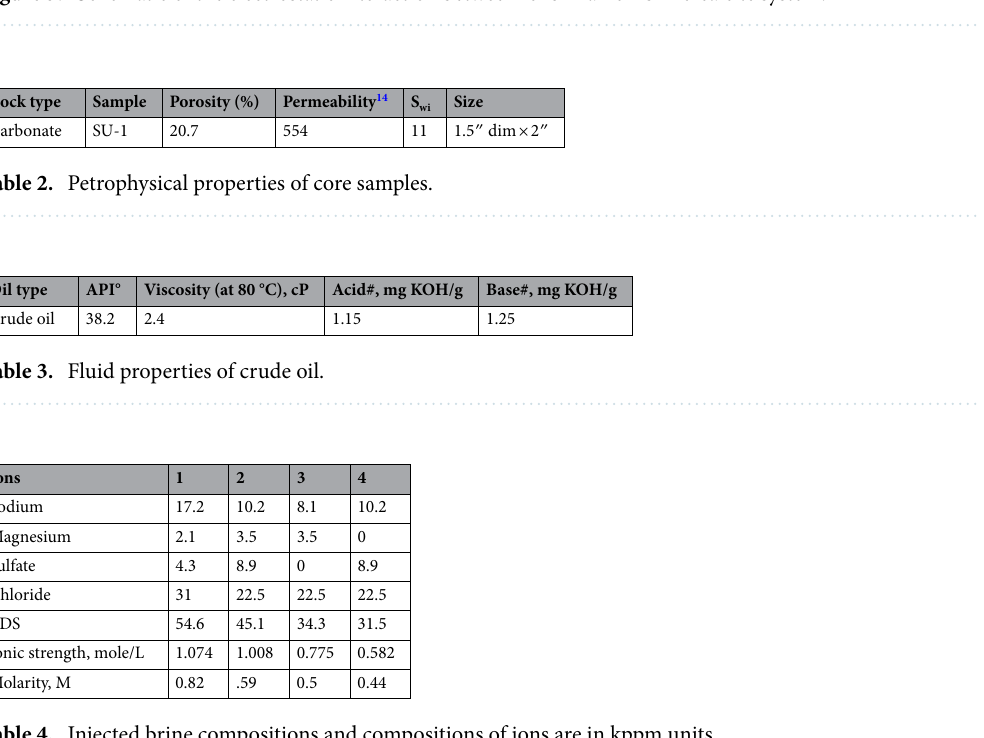
Figure 3. Schematic of the electrostatic interaction between ions in an oil-brine-calcite system.